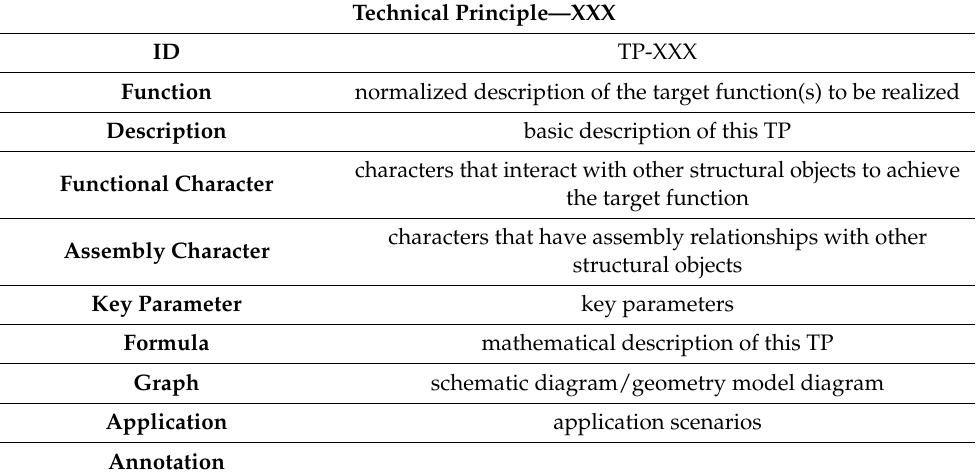
Table 2. The representation template of technical